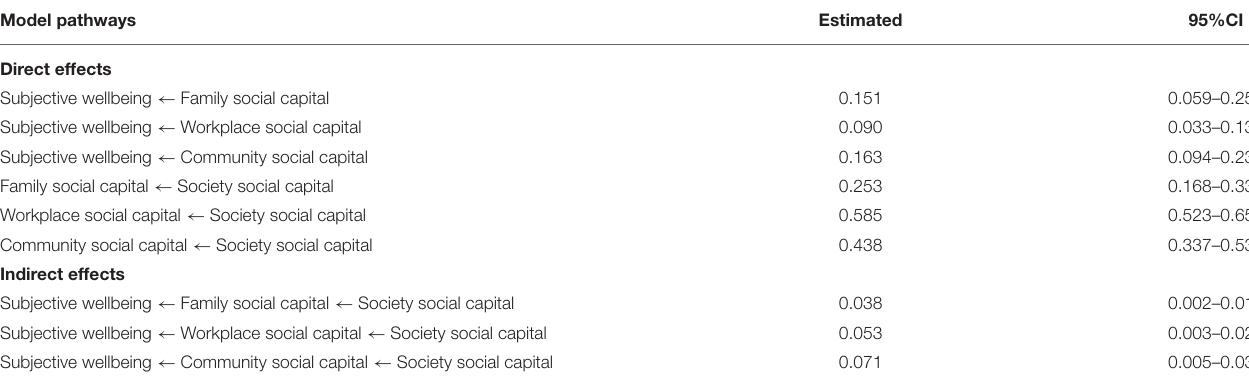
TABLE 3 | The path coefficients between social capital and subjective